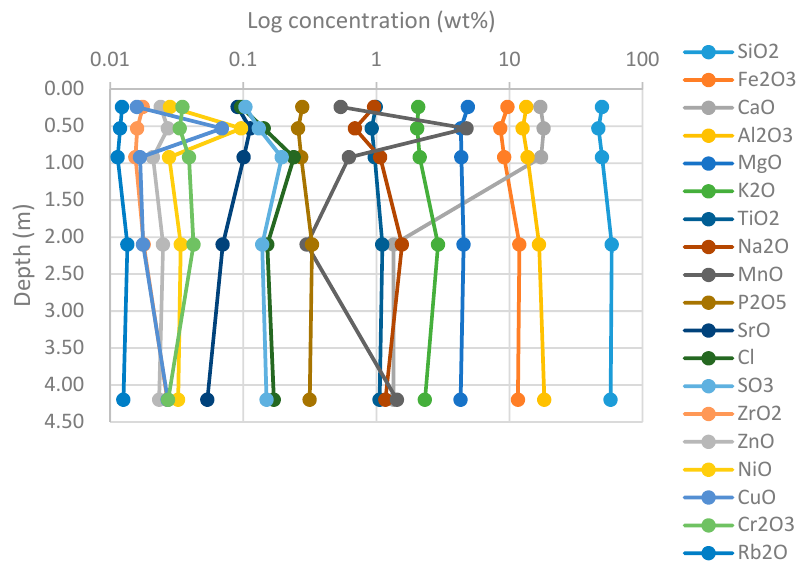
Figure 8. XRF data for bentonite in borehole KM3 (normal-log plot). All depths are from the base of the overlying limestone.